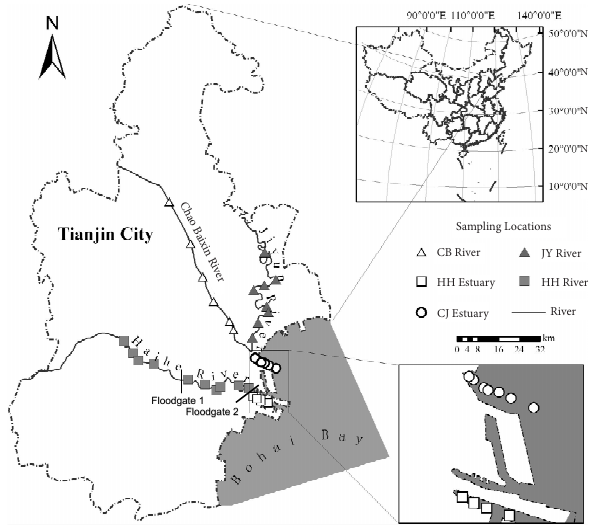
Figure 1. Sampling locations for the three investigated